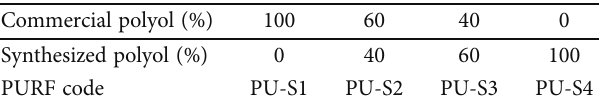
Table 1: Codes of PURFs from commercial polyol and novel polyol with di ff erent ratios.